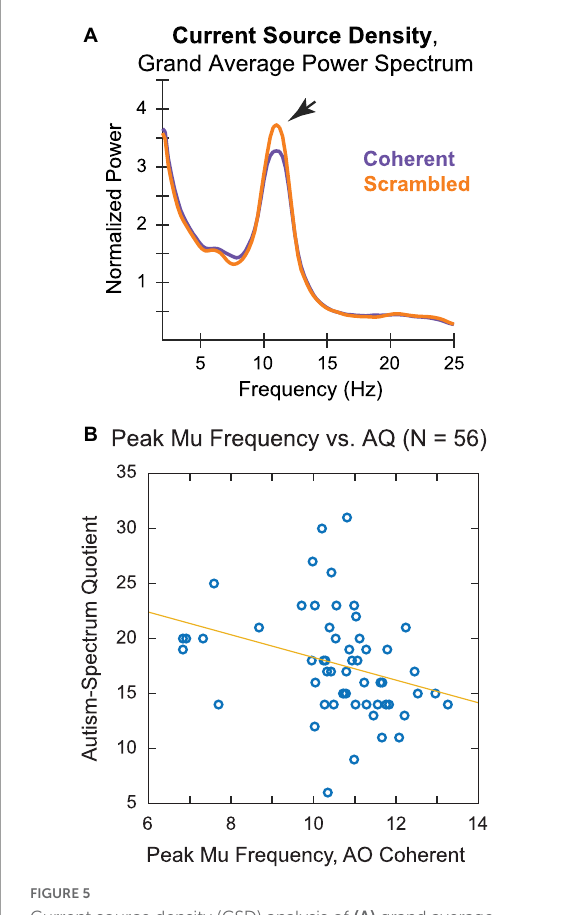
FIGURE5 Current source density (CSD) analysis of (A) grand average power spectrum and (B) correlation of individual PMF during action observation of biologically plausible PLDs with AQ